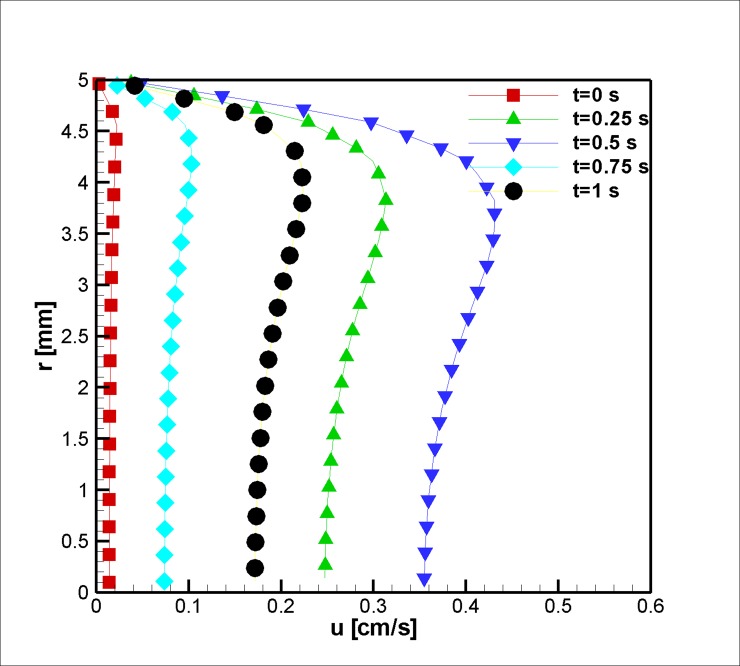
Velocity in the axial direction at the stenosis peak at z = 2 cm for the case of Joule heating, Lvessel = 7 cm, Rvessel = 1 cm and fifty percent stenosis.